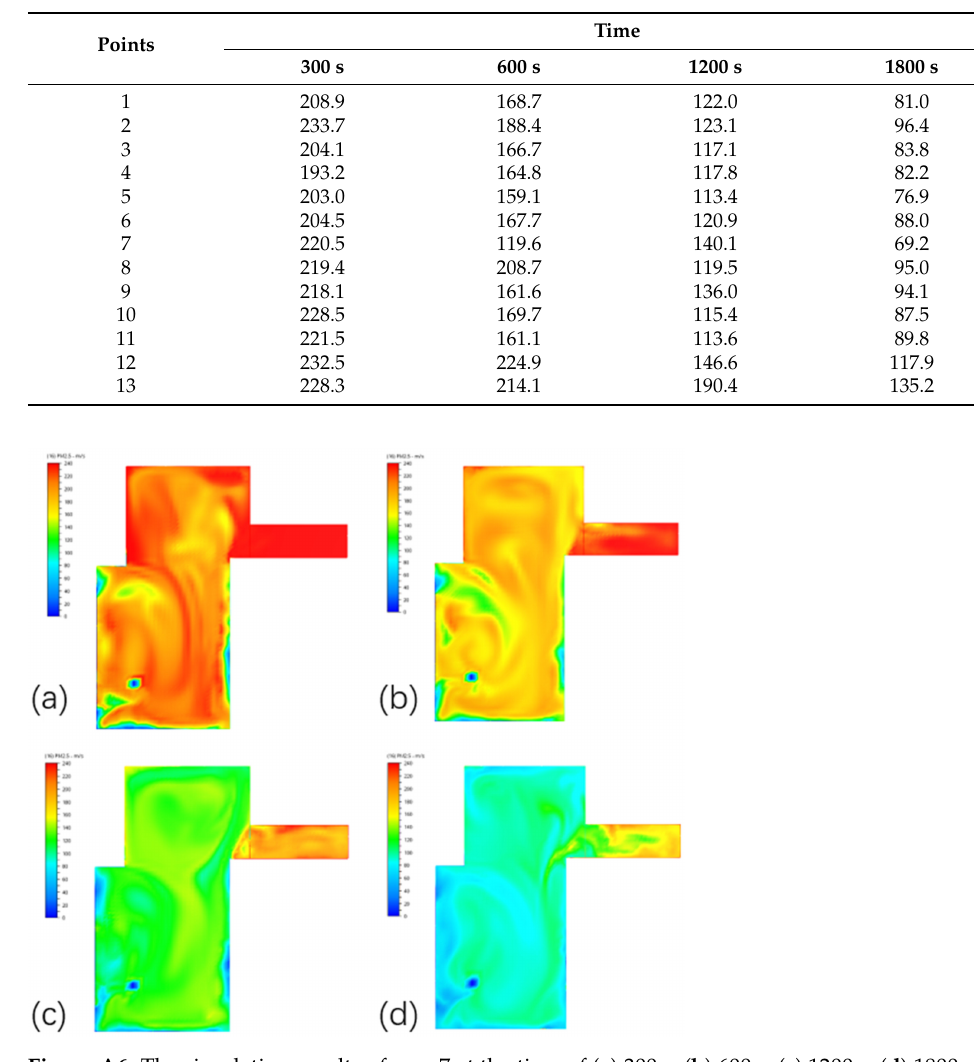
Figure A6. The simulation results of case 7 at the time of ( a ) 300 s; ( b ) 600 s; ( c ) 1200 s; ( d ) 1800